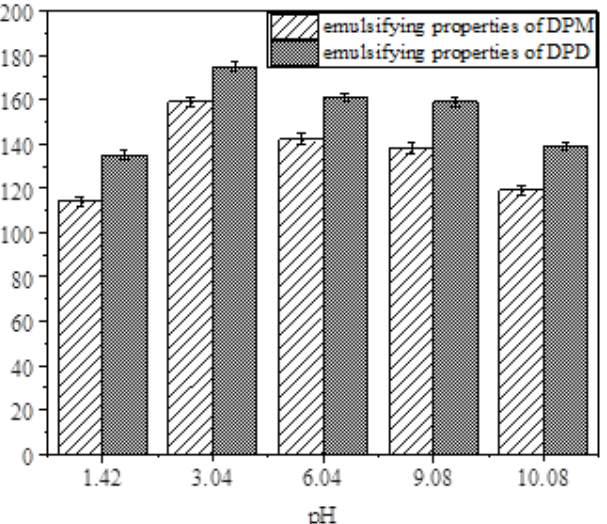
Figure 7. Emulsification properties.